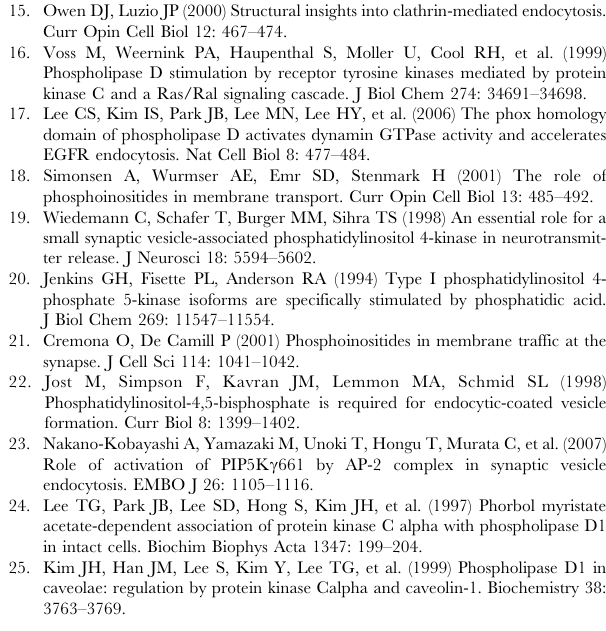
Figure S1 Binding region mapping of PLD1 for m 2. (A) Schematic depictions of PLD1 fragments. (B–E) The interaction between PLD1 and m 2 was analyzed by pull-down assay and western blotting. The same amounts of GST alone or GST fusion PLD1 fragments (B), PLD1 PX domain and the PH domain (C), fragments of the PLD1 PH domain (D), and PH domains from PLD1, PLC b -1, IRS-1, and dynamin-1 (E) were incubated with purified m